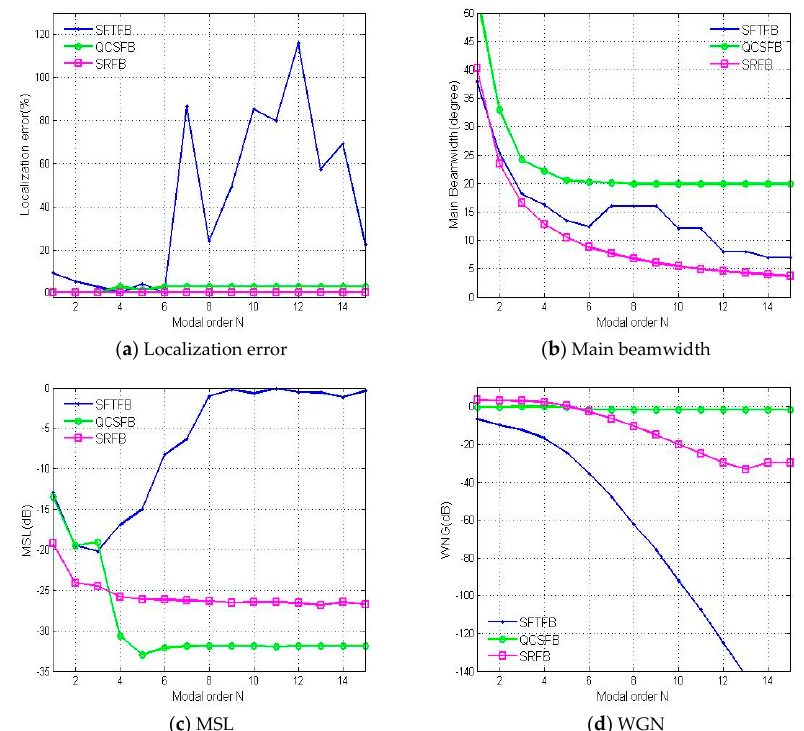
Figure 6. The performance of the three methods investigated based on the ( a ) localization error, ( b ) main beamwidth, ( c ) MSL and ( d ) WNG with respect to the modal order.